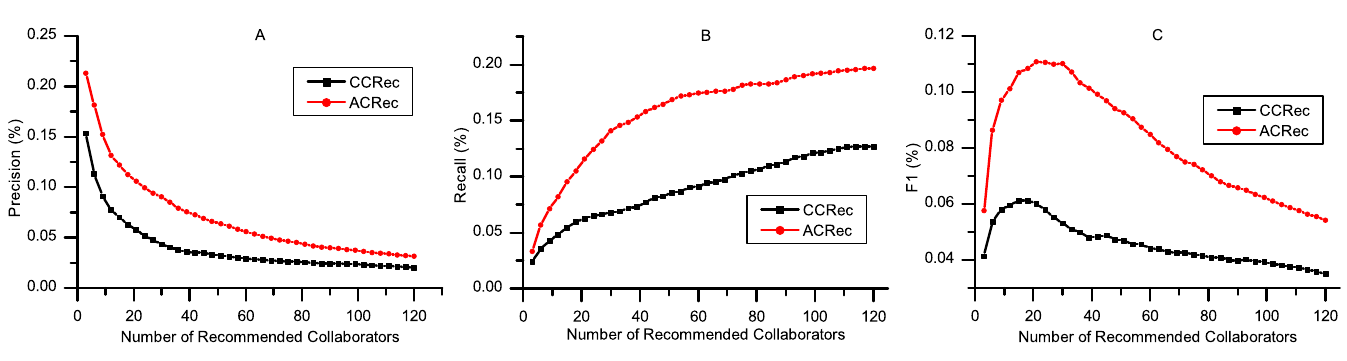
Fig 3. Performance of CCRec and ACRec on most valuable collaborators recommendation. The abscissas denote the length of recommendation list. The ordinates respectively represent the values of precision, recall and